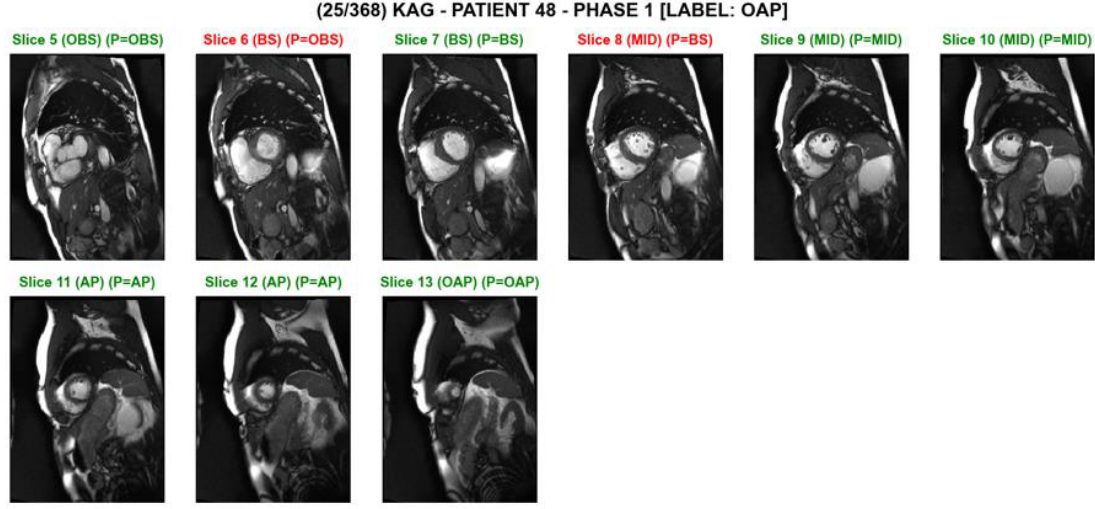
Figure 3. A screenshot of slice level predictions on a series of short axis slices on an individual test subject. The prediction was made by the ‘MobileNet_2layerLSTM’ model. The slice index, the ground truth, and the predicted category are shown above each image. The green text indicates correct classification, while the red text indicates incorrect classification. For example, ‘(BS) (P = OBS)’ indicates that the ground truth is ‘basal’ , and the model’s prediction is ‘out -of-bas al’.